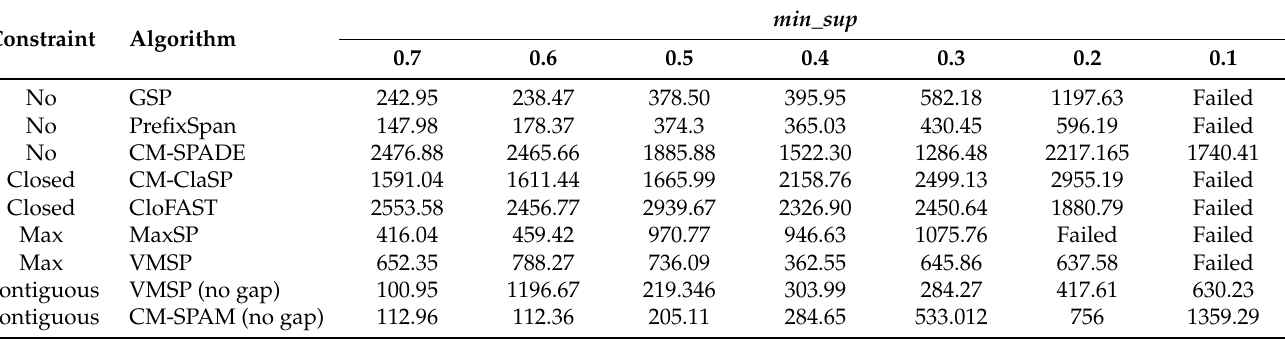
Table 4. RAM consumption(MB) of Algorithms with different minimum support ( min _ sup ) catego- rized by their